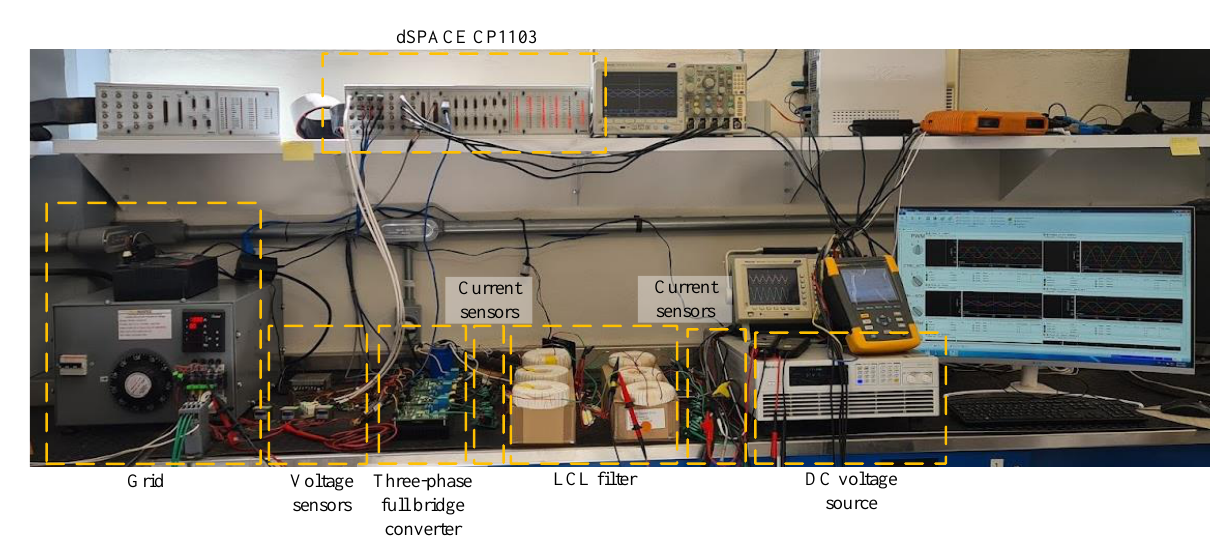
Figure 16. Laboratory implementation.